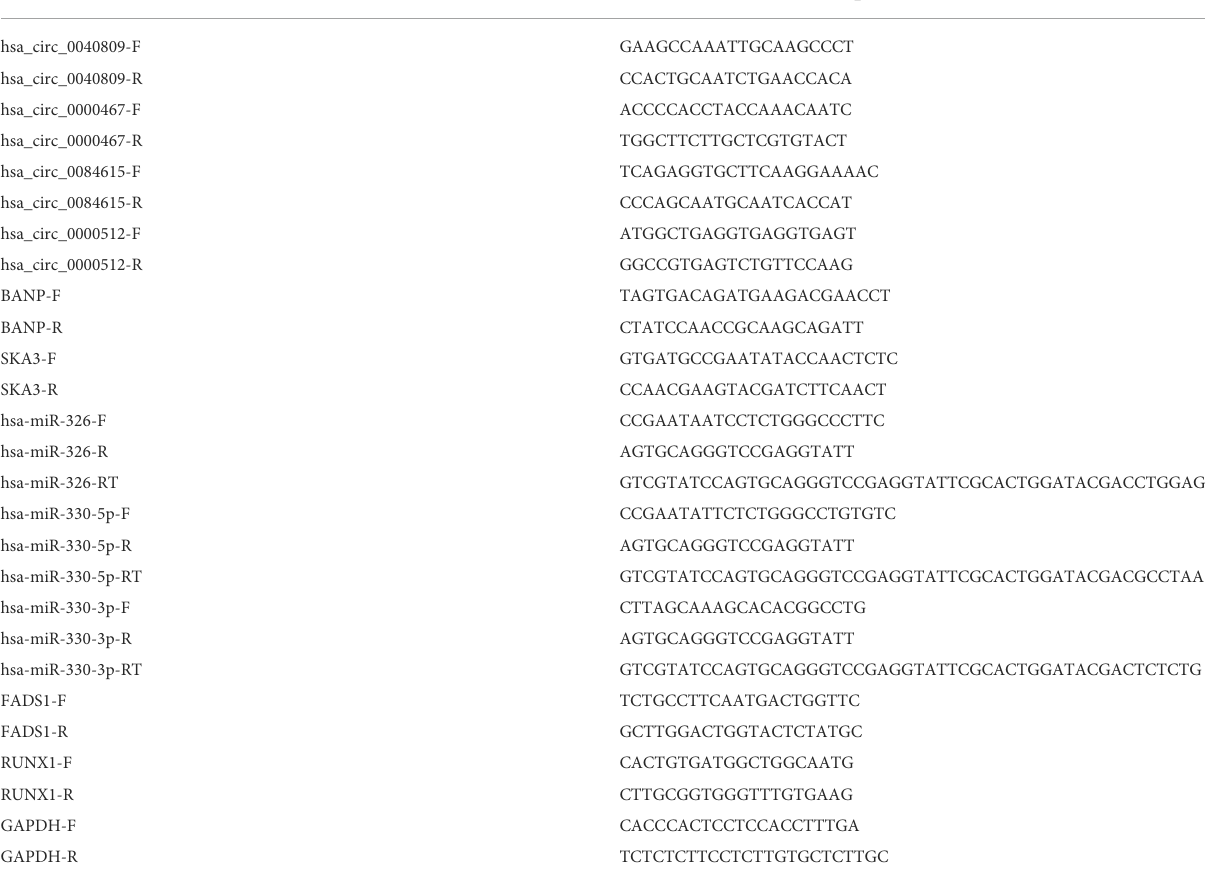
TABLE 1 Sequences of circRNAs, miRNA, mRNA and GAPDH used for qRT-PCR. Primer